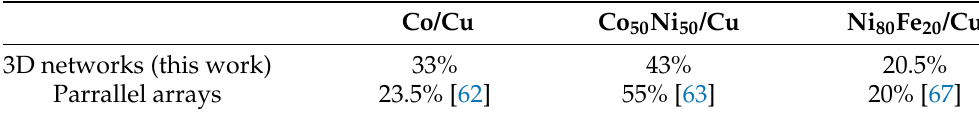
Table 1. Highest values reported to date of the room temperature giant magnetoresistance ratio for crossed FM/Cu nanowire networks compared to previous measurements on parallel nanowire